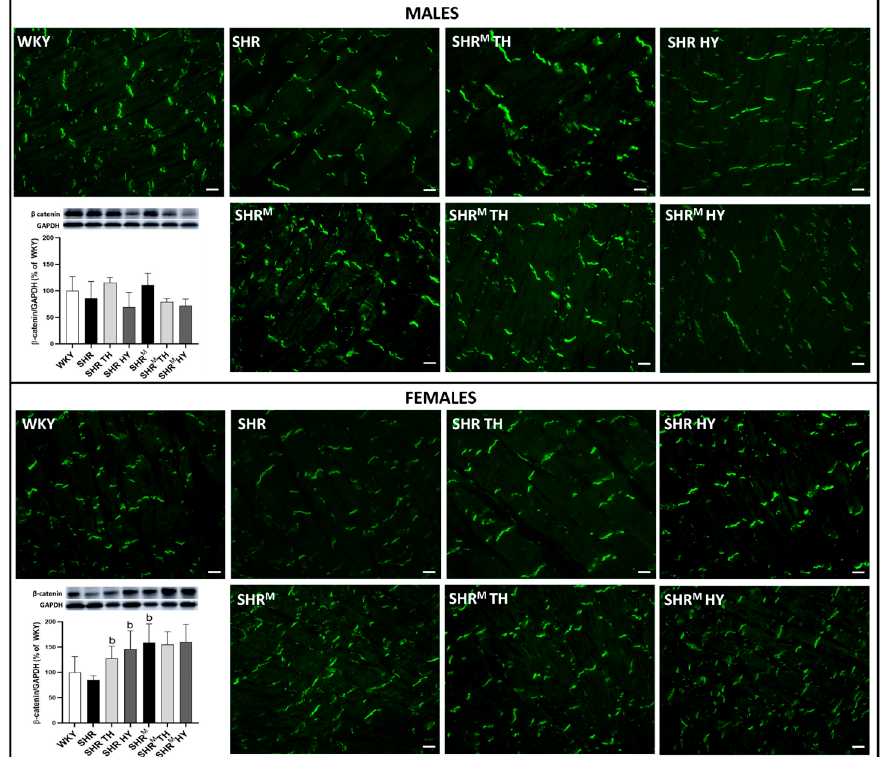
Figure 8. Detection of the myocardial topology in β -catenin (green) using immunofluorescence labeling. Graphs represent quantification of protein levels of β -catenin determined by Western blot analysis. Note the enhanced β -catenin in hairless SHR M males and, to a lesser extent, in females compared to the wild type strain. WKY—Wistar Kyoto normotensive control rats, SHR—wild type spontaneously hypertensive rats, TH—hyperthyroid rats, HY—hypothyroid rats, SHR M —hairless spontaneously hypertensive rats, n = 5 per group. Scale bar represents 400 μ m. Data are presented as means ± SD, b p < 0.05 vs. SHR. One-way ANOVA and Bonferroni’s multiple comparison test were used as the statistical method.